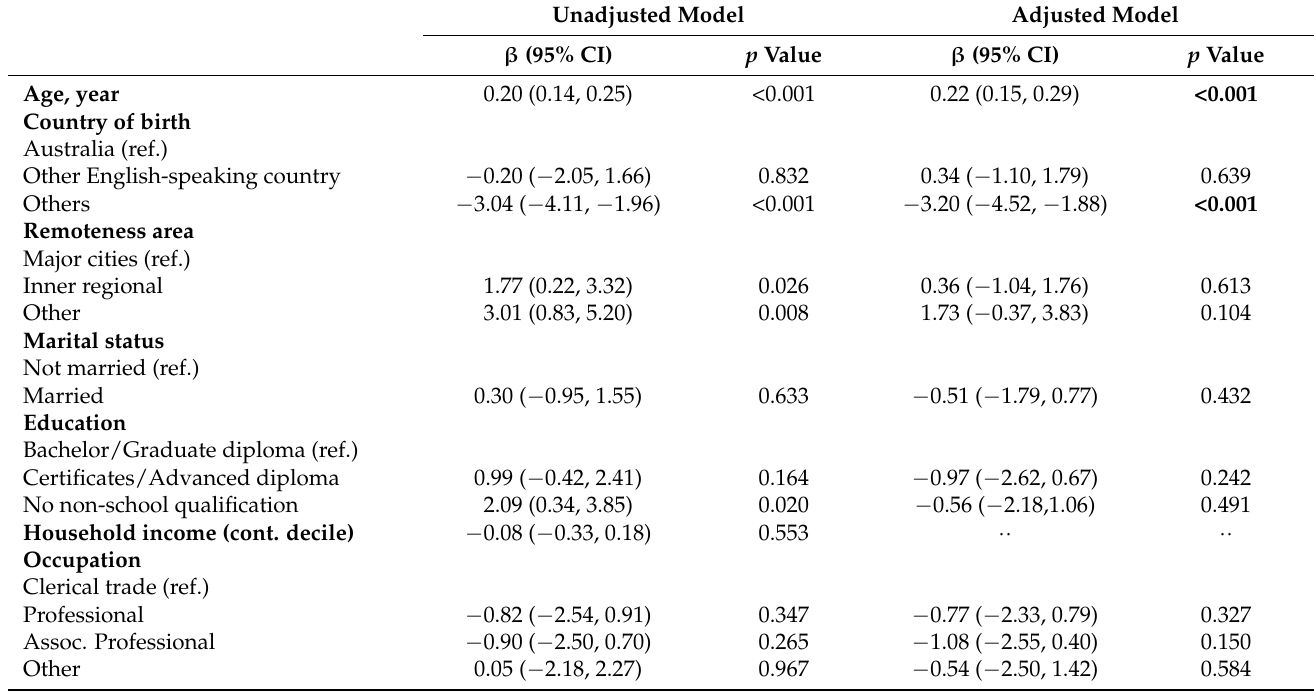
Table 4. Associations between diet and physical activity and BMI in pre-pregnant women (N = 755). Unadjusted